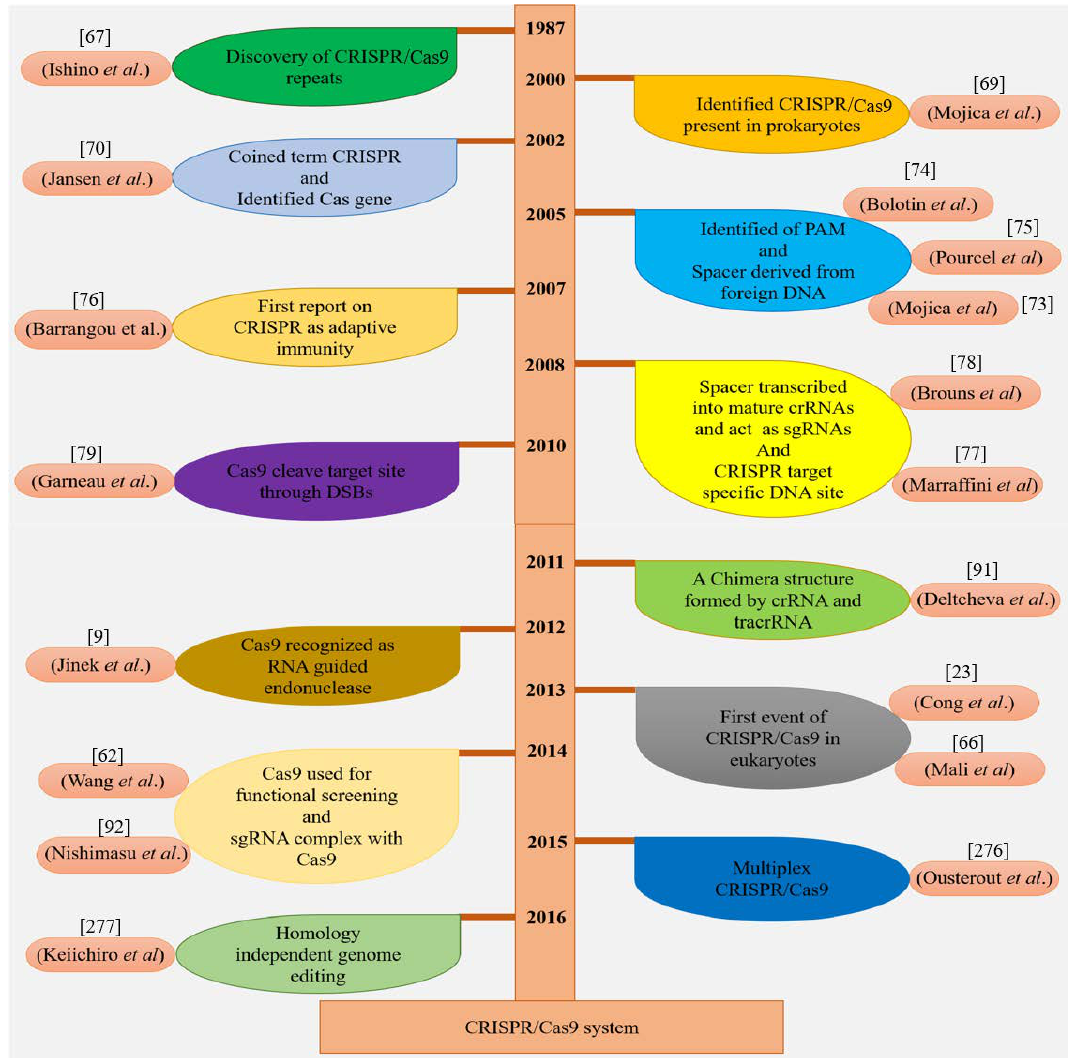
Figure 4. Historical chart illuminating key developments in the CRISPR / Cas9